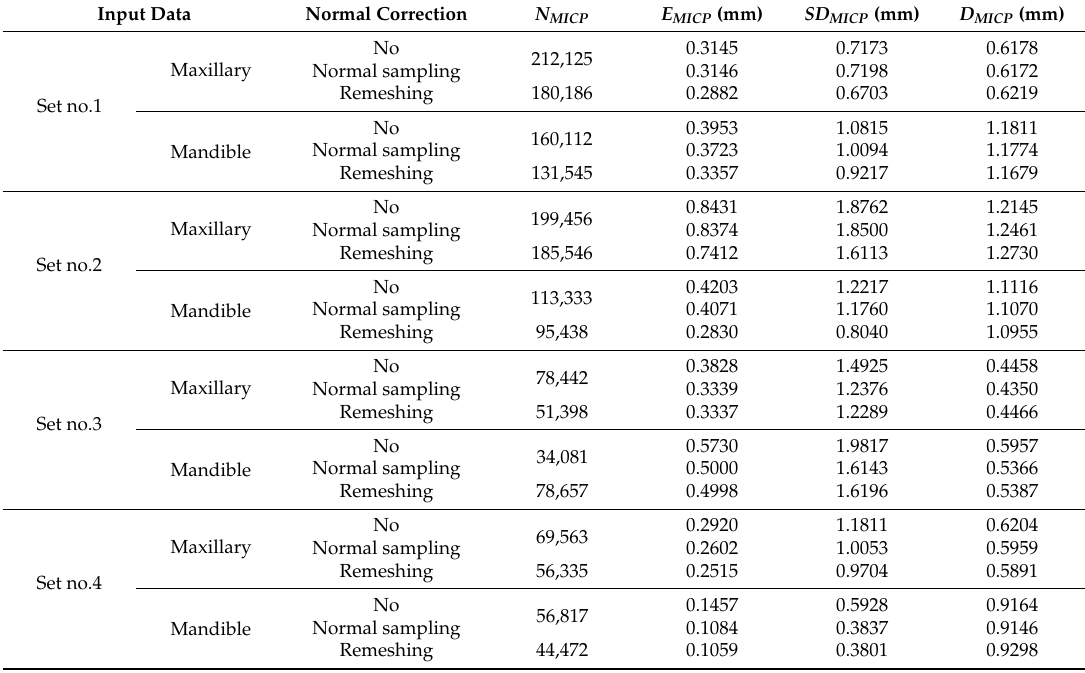
Figure 7. Registration result of modified iterative closest point (MICP) after normal correction.